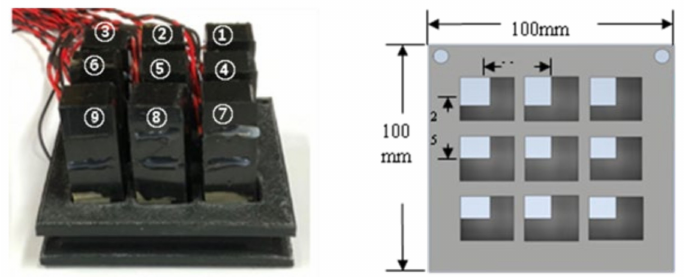
Figure 3. Plane array of smart skin sensors and designed